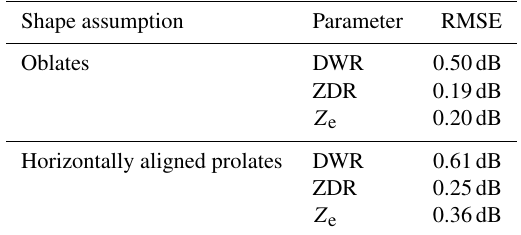
Table 2. RMSE values between simulated and observed ZDR, DWR, and Z e values for the whole radar cross-section after run- ning the retrieval for 30 January 2019 at 10:08UTC using oblate and horizontally aligned prolate ice spheroids and assuming their m(D max ) to be the aggregates from Yang et al.